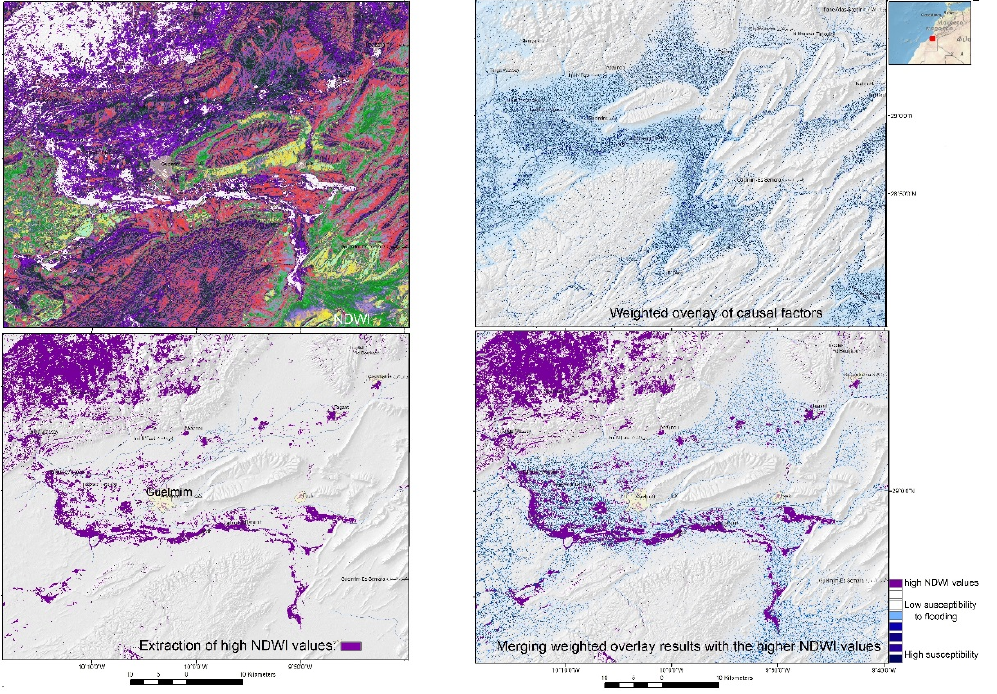
Figure 14. Overlay of the higher NDWI values with the weighted overlay results. The highest NDWI values (white, violet) within the Guelmim basin can be identified in areas with the highest susceptibility to flash floods due to their morphometric properties and